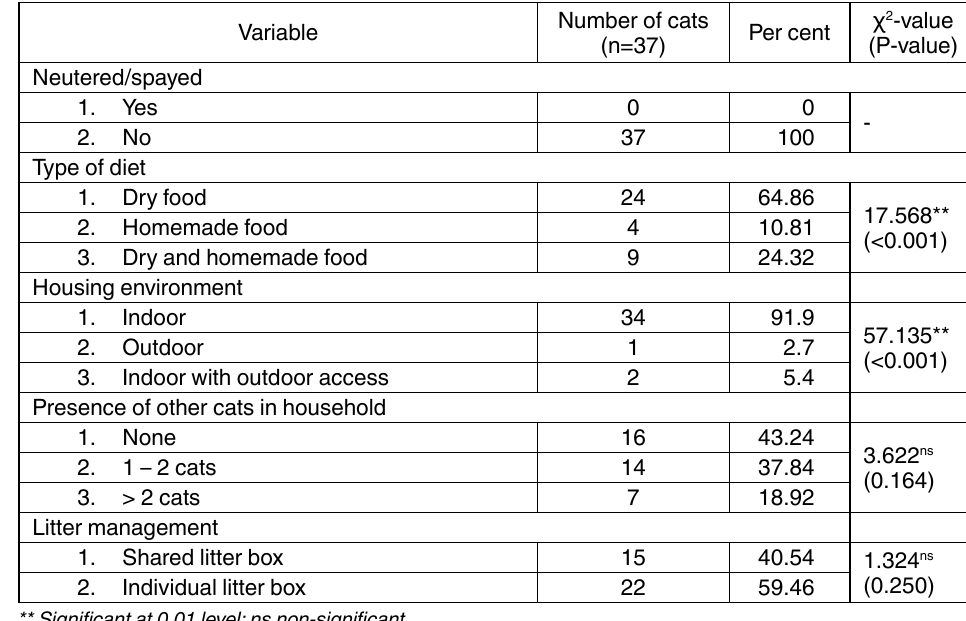
table 5. Management factors associated with FLUTD